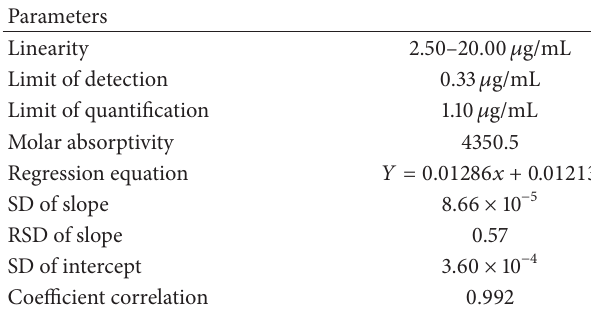
Table 2: Analytical parameters of calibration curves of copper (II)- reagent ( 𝑛 = 9 ).